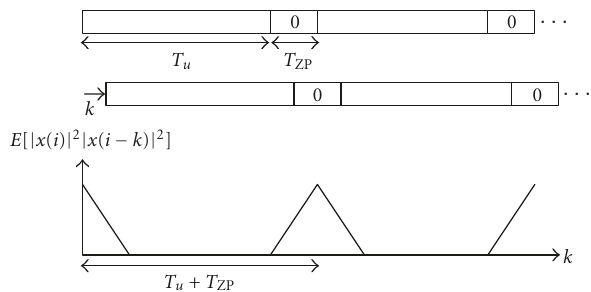
Figure 4: Power autocorrelation on a ZP-OFDM